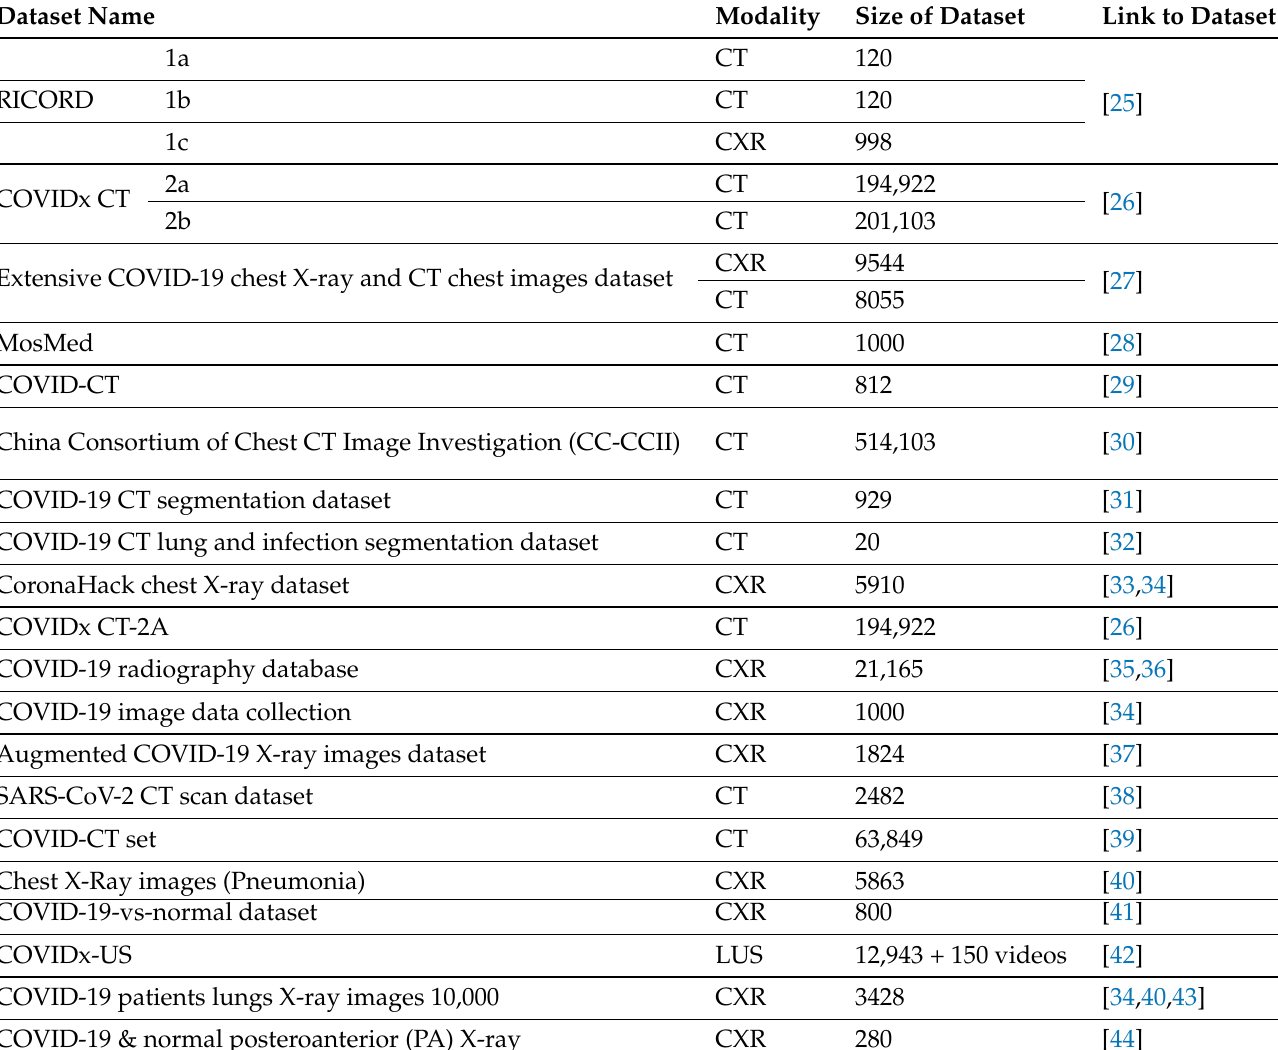
Table 1. Publicly available COVID-19 CT scan